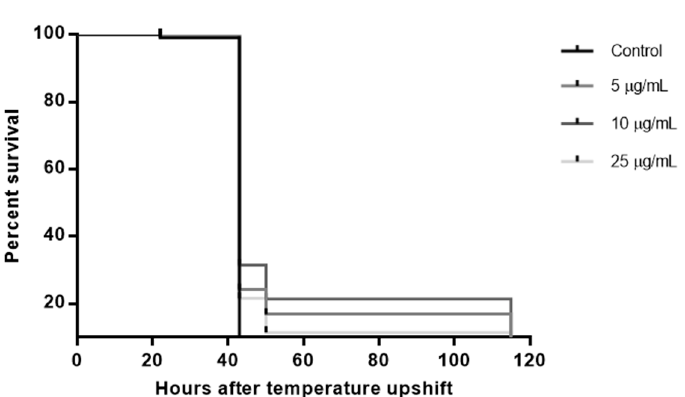
Figure 4. Effect of RT extracts on A β -induced paralysis in transgenic C. elegans CL4176. The statistical significance of the difference between the curves was analyzed using a log-rank (Kaplan–Meier) statistical test, which compares the survival distributions between the control and treatment groups. Differences in the survival curves between the treatment and control groups were found ( p < 0.0001).